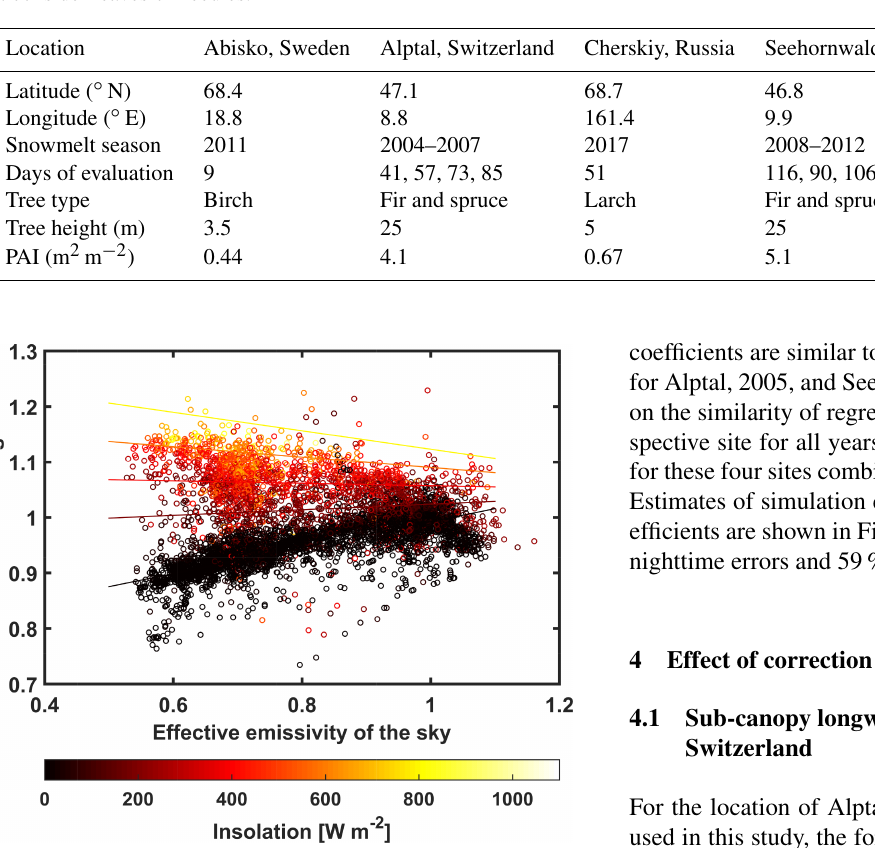
Table 1. Forest stands used for calculation of correction factors based on simulations by Todt et al. (2018). Vegetation density is given as plant area index (PAI), the one-sided area of plant components per unit ground surface area including stems, branches, and leaves or needles. Abisko and Cherskiy feature deciduous vegetation so that trees were leafless throughout the simulation periods, and PAI values do not consider leaves or needles.